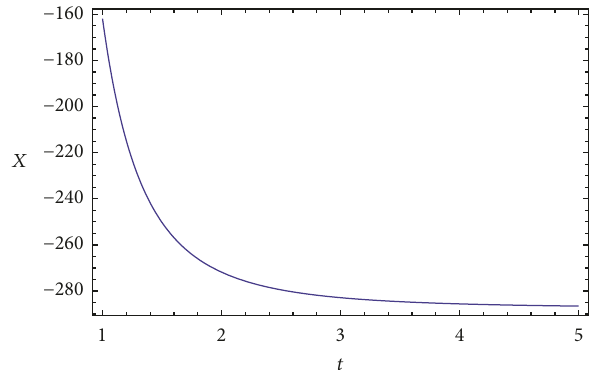
̇𝑆 Figure 15: Plot of tot by taking power law entropy as entropy at event horizon.